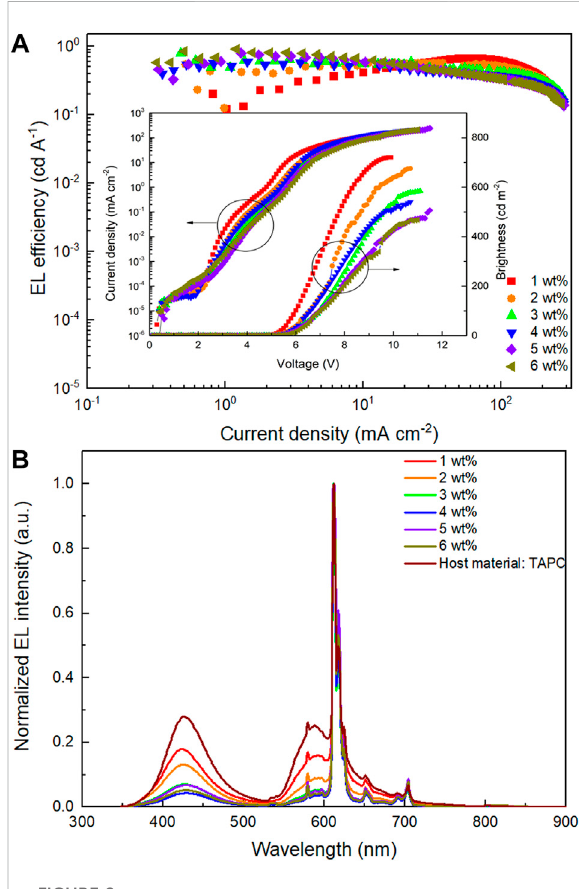
FIGURE 3 (A) EL ef fi ciency-current density ( η -J ) characteristics of devicesA,B,C,D,andM.Inset:currentdensity-brightness-voltage ( J-B-V ) characteristics of devices A, B, C, D, and M. (B) Normalized ELspectraofdevicesA,B,C,D,andManddevicespossessing host material only TAPC or TcTa operating at 10 mA cm − 2